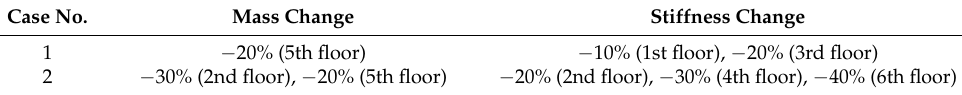
Table 3. Damage cases.